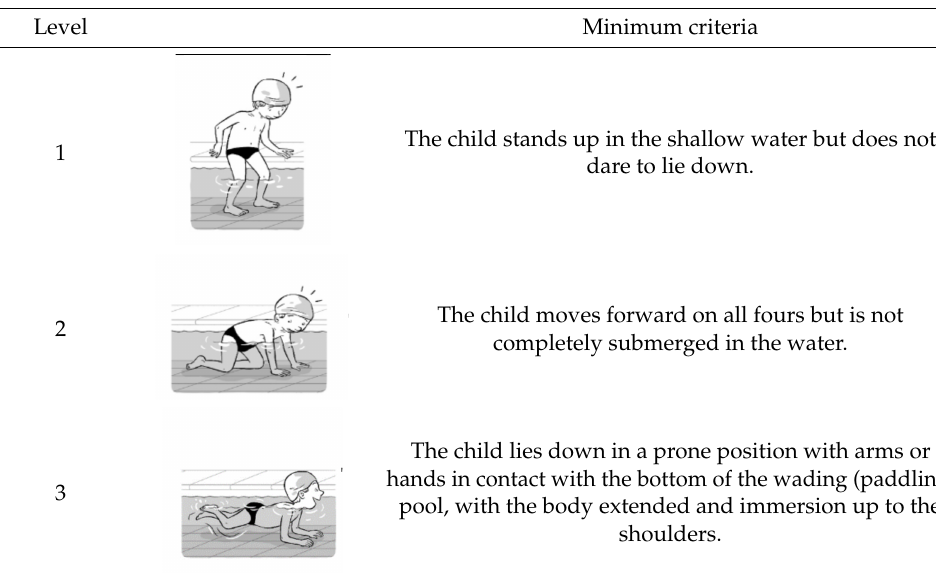
Table 3. Example of the minimum criteria per mastery level for test item 1 of the PSPWC [24], when performed by the child in the water of an indoor swimming pool during the Actual Aquatic Skills Test (AAST)